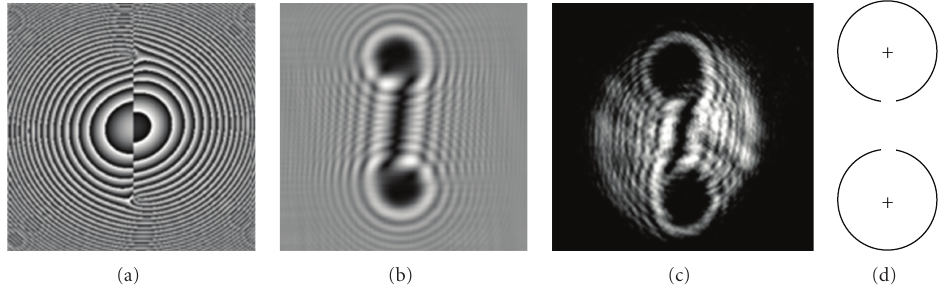
Figure 5: Fresnel lens with fractional vortices of the same charge (3.5) embedded at o ff -axis locations. (a) Phase distribution displayed on SLM. (b) Simulated intensity distribution near the focal plane. (c) Experimentally observed intensity distribution near the focal plane. (d) Distribution of topological charge in the intensity pattern.